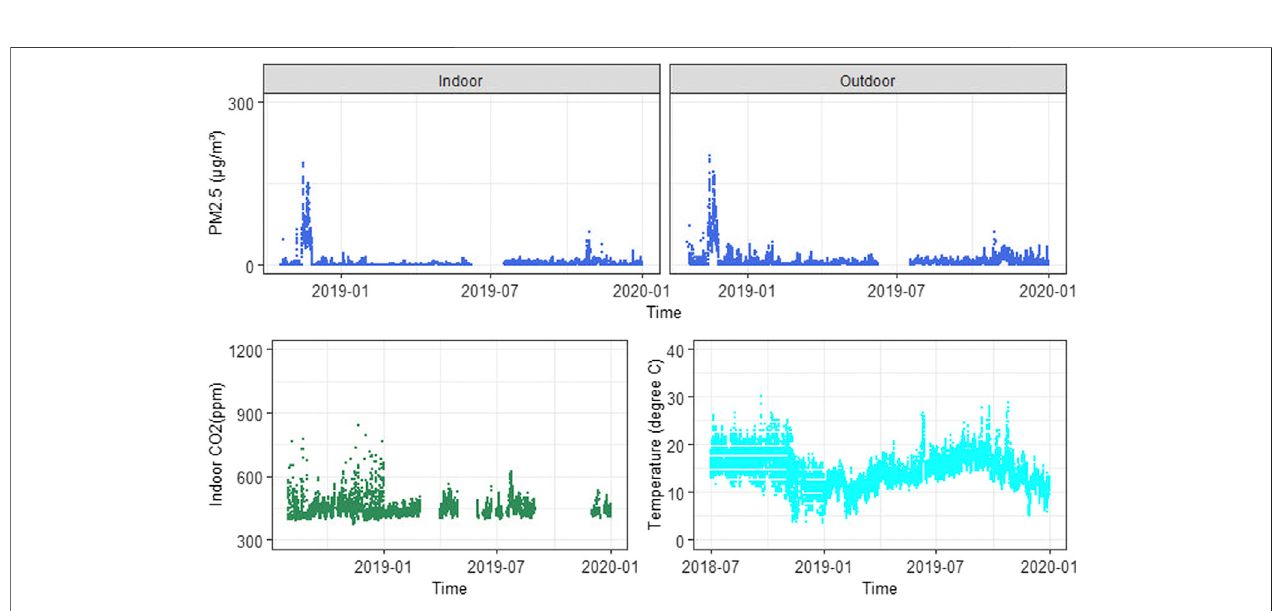
FIGURE 3 | Time variance of indoor and outdoor PM 2.5 , CO 2 , and